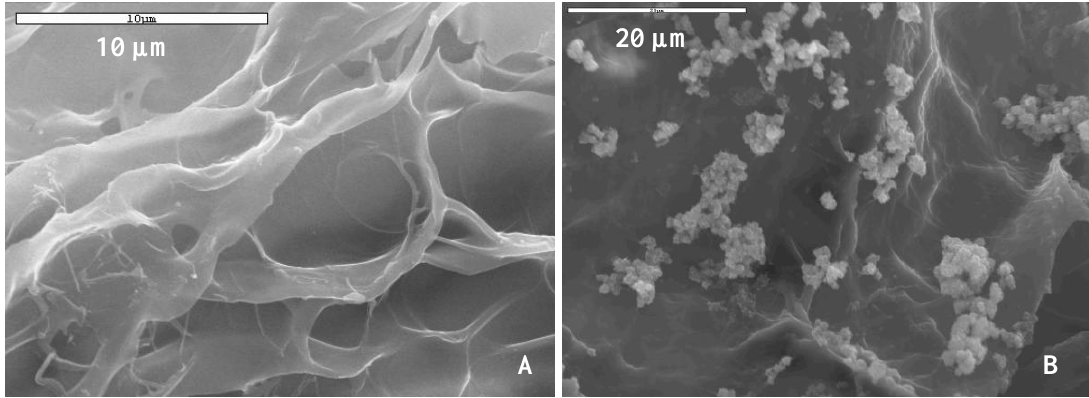
Figure 4. High-magnification SEM and EDS of the surface of collagen sponges. ( A ) Untreated, non-mineralized collagen sponge. ( B ) Collagen sponge mineralized via the conventional crystallization process, with no polymer